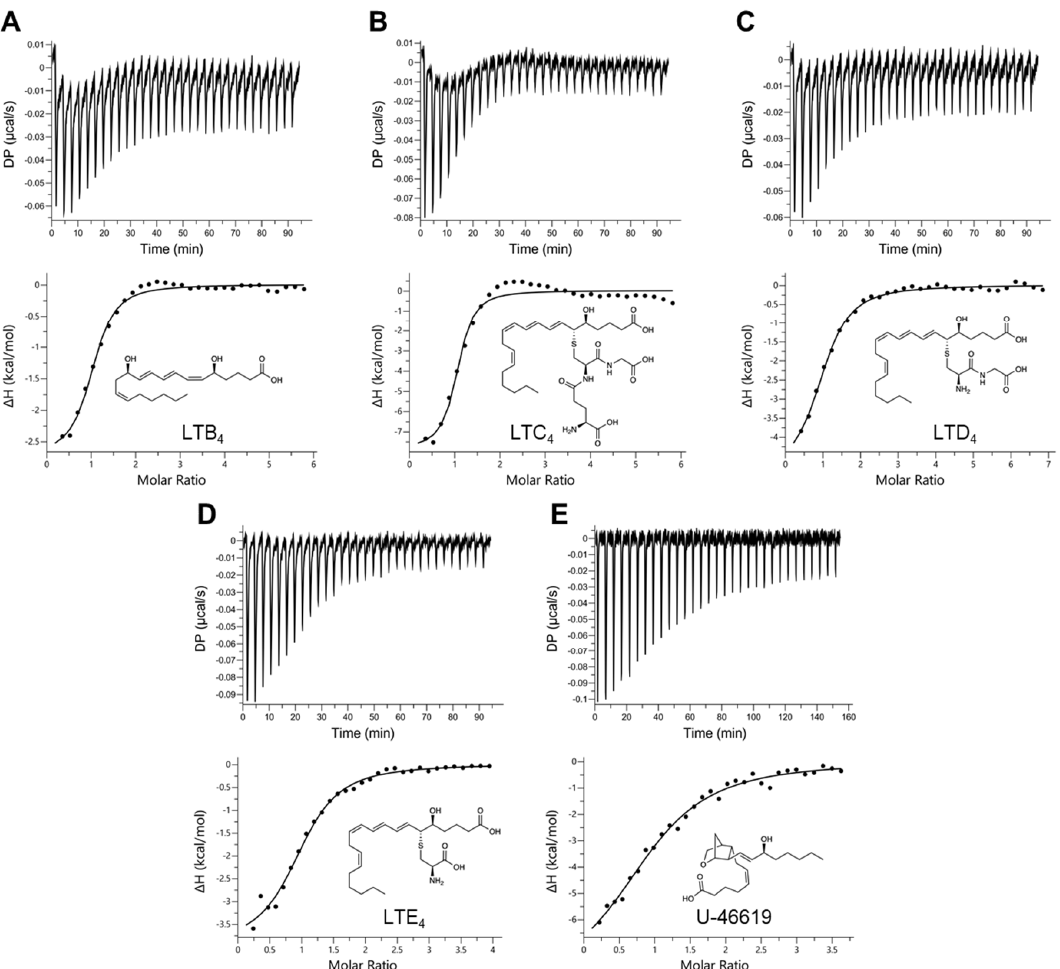
Figure 4. Binding of AlboD7L1 to biolipids by isothermal titration calorimetry. Binding experiments were performed on a VP-ITC microcalorimeter. The upper curve in each panel shows the measured heat for each injection, while the lower graph shows the enthalpies for each injection and the fit to a single-site binding model for calculation of thermodynamic parameters. Binding of AlboD7L1 to LTB 4 ( A ), LTC 4 ( B ), LTD 4 ( C ), LTE 4 ( D ), and U-46619 ( E ). The insets show the names and chemical formulas for these compounds.